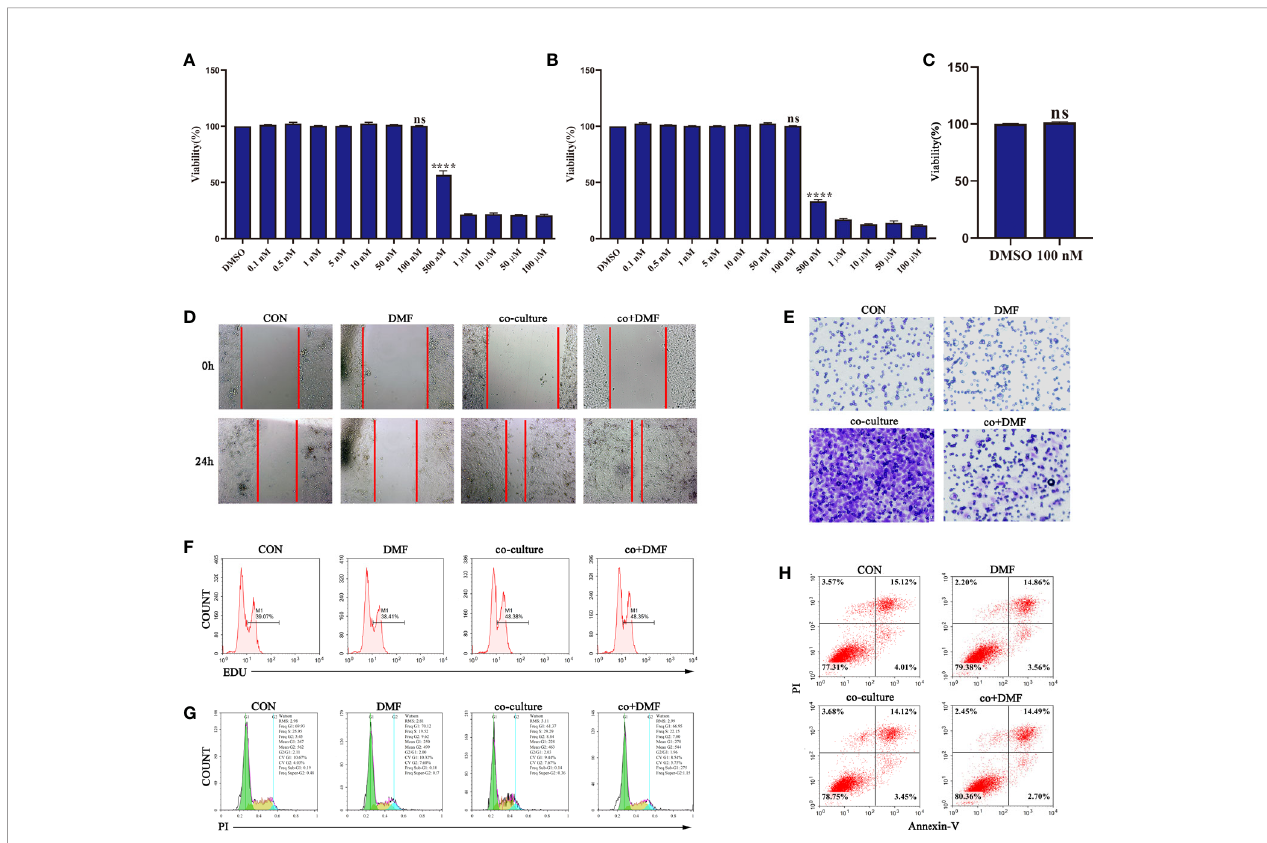
FIGURE 1 | Dimethyl formamide (DMF) inhibits the pro-invasion ability of tumor-associated macrophages (TAMs). (A) The viability of RAW264.7 cells was detected by MTT assay after treatment with different concentrations of DMF for 24 h. (B) The viability of RAW264.7 cells was detected by MTT assay after treatment with different concentrations of DMF for 48 h. (C) The viability of 4T1 tumor cells was evaluated by MTT assay after treatment with 100 nM DMF for 48 h. (D – H) In the presence or absence of DMF, 4T1 tumor cells were cultured alone or co-cultured with RAW264.7 cells for 48 h. Scratch migration assay (D) , invasion assay (E) , proliferation assay (F) , cycle analysis (G) , and apoptosis analysis (H) were performed. Data are presented as the mean ± standard error and represent at least three independent experiments with three replicates. ns, no signi fi cance; **** P < 0.0001 as determined by the one-way ANOVA